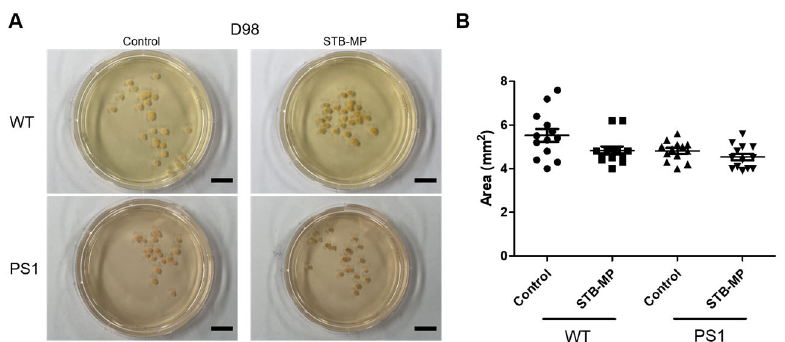
Figure A2. Cortical brain organoid size differences after STP-MP treatment. ( A ) Images of control group and STB-MP treated group of WT and PS1 cortical organoid. Scale bar, 1 cm. ( B ) Area measured of control and STB-MP treated organoid of WT and PS1 cortical organoid. N = 10, each data point represents a single organoid.